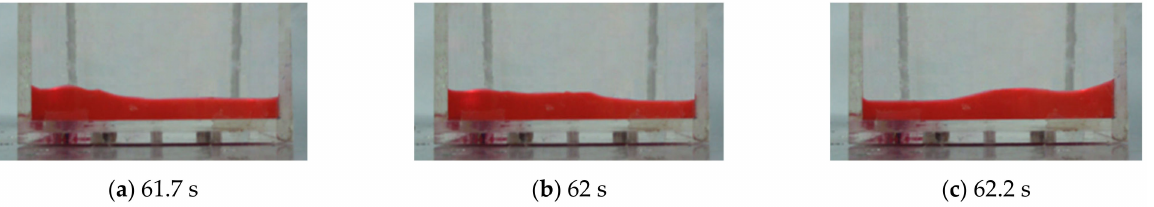
Figure 14. Still shots of wave propagation wave recorded by the video camera.